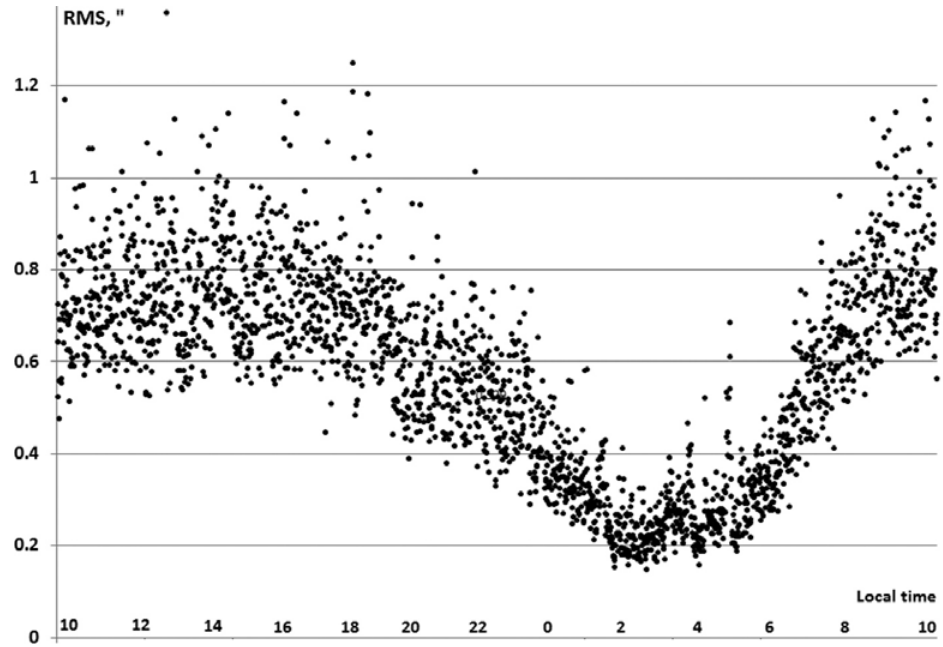
Fig. 3. RMS of tiltmeter position (estimated using series of 100 readings) during a day